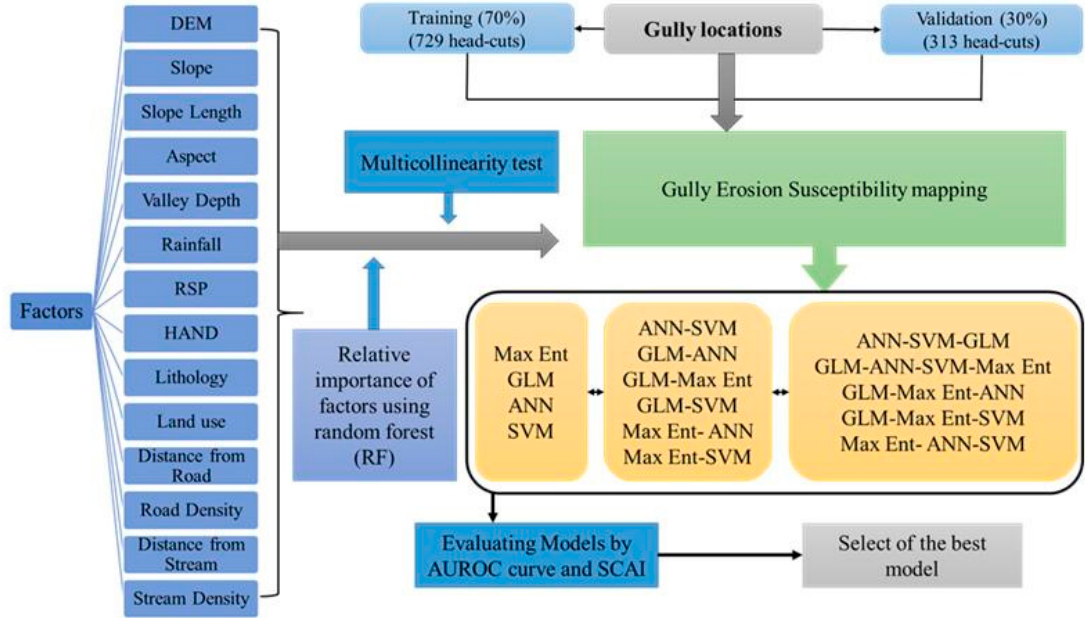
Figure 2. Flowchart of research in the study area.